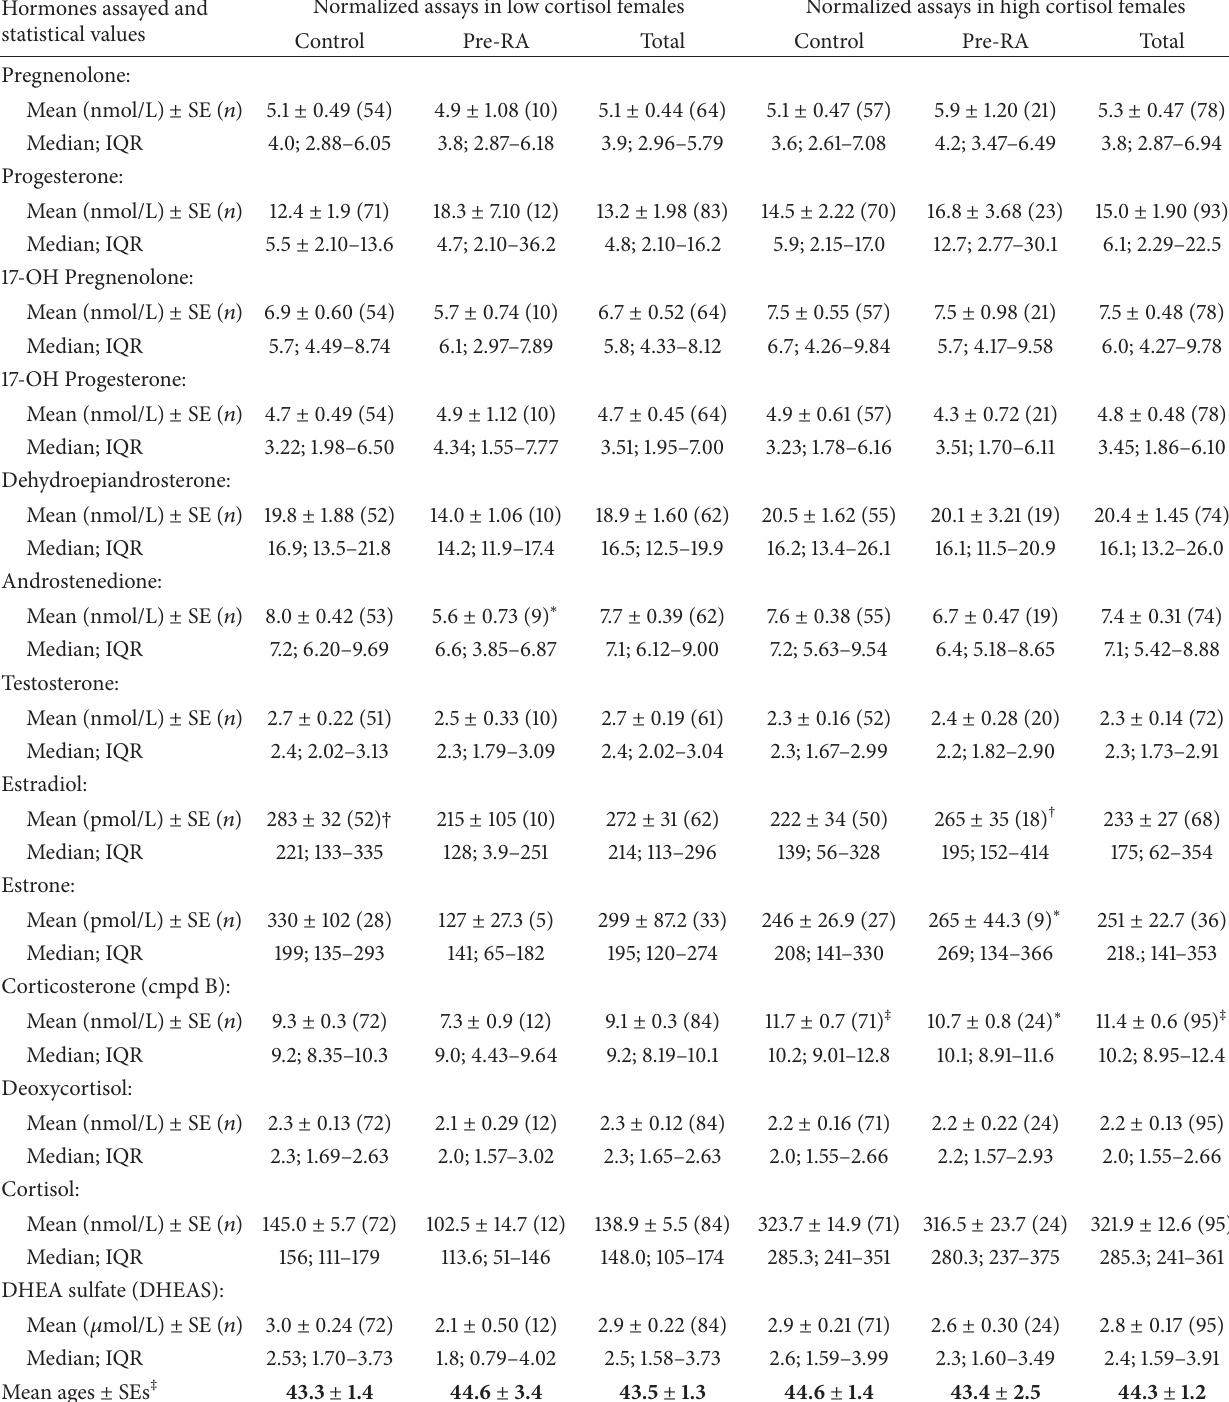
Table 2: Normalized assays in CN and Pre-RA Subjects having lower versus higher cortisol values than the total female mean. Normalized assays in low cortisol females Normalized assays in high cortisol females Hormones assayed and statistical values Control Pre-RA Total Control Pre-RA